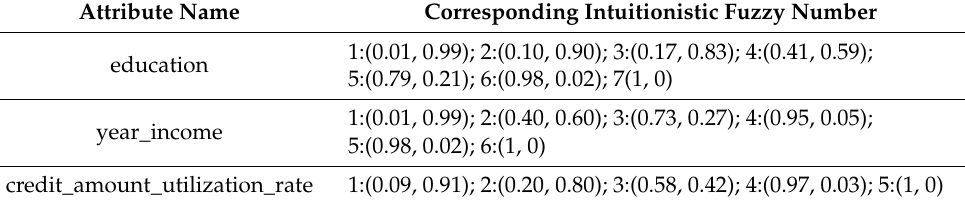
Table 6. Fuzzification